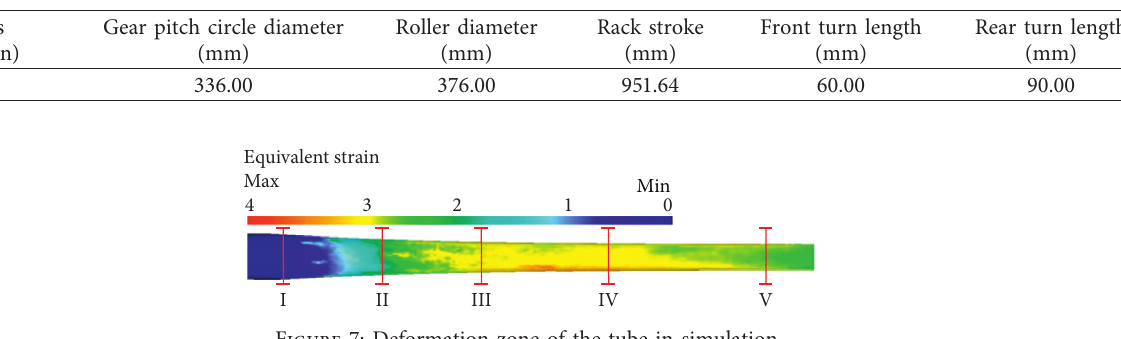
Figure 6: FEM of pilgering. Table 4: Rolling process parameters.